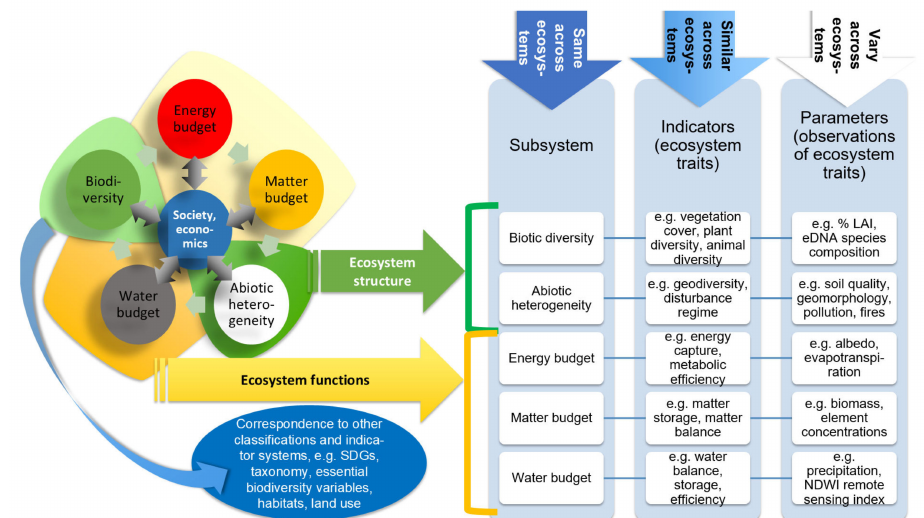
Figure 2. Semantic compatibility of the Methodological Framework: Translating highly variable ecosystem structure and functions to a coherent set of indicators and parameters (general principle and hierarchy of ecosystem subdivision). Adapted from [26,57].